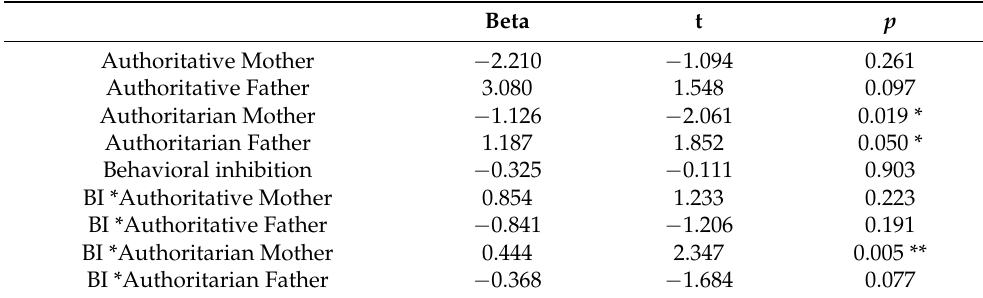
Table 4. Regression analysis for boys’ reactive aggression including parenting styles and behav- ioral